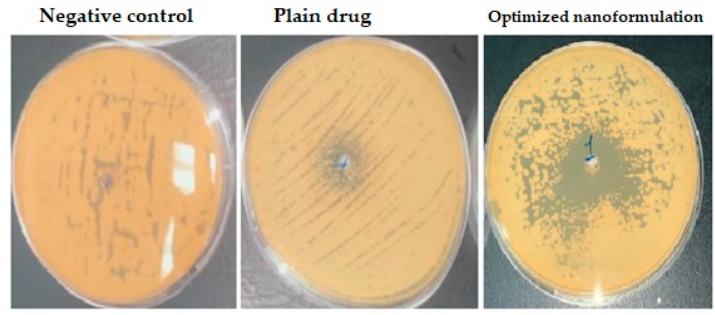
Figure 6. In vitro antifungal susceptibility testing.